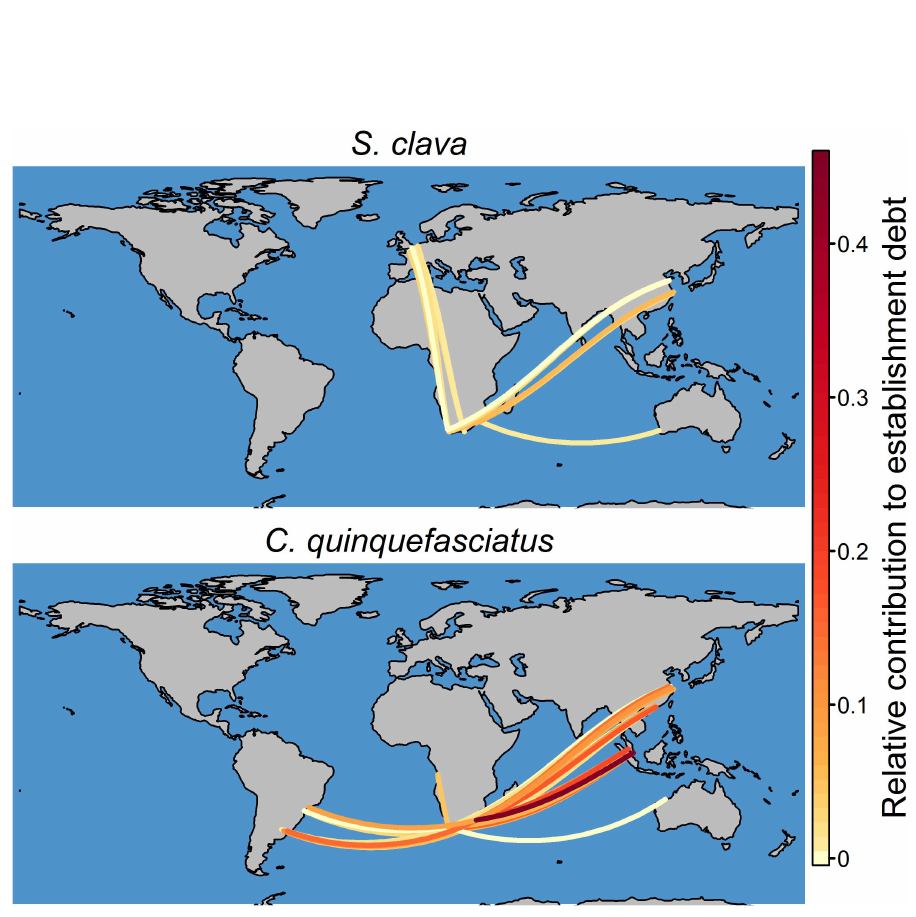
Fig 5. The high risk shipping routes which may facilitate the introduction of the marine tunicate Styela clava and the mosquito Culex quinquefasciatus to South African ports. The depictedroutes are not the actual routes followedby